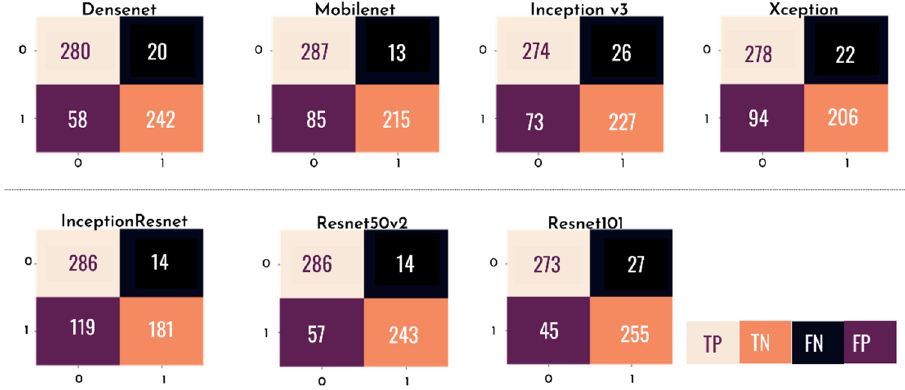
Figure 12. Confusion matrix of each of the individual CNN models.